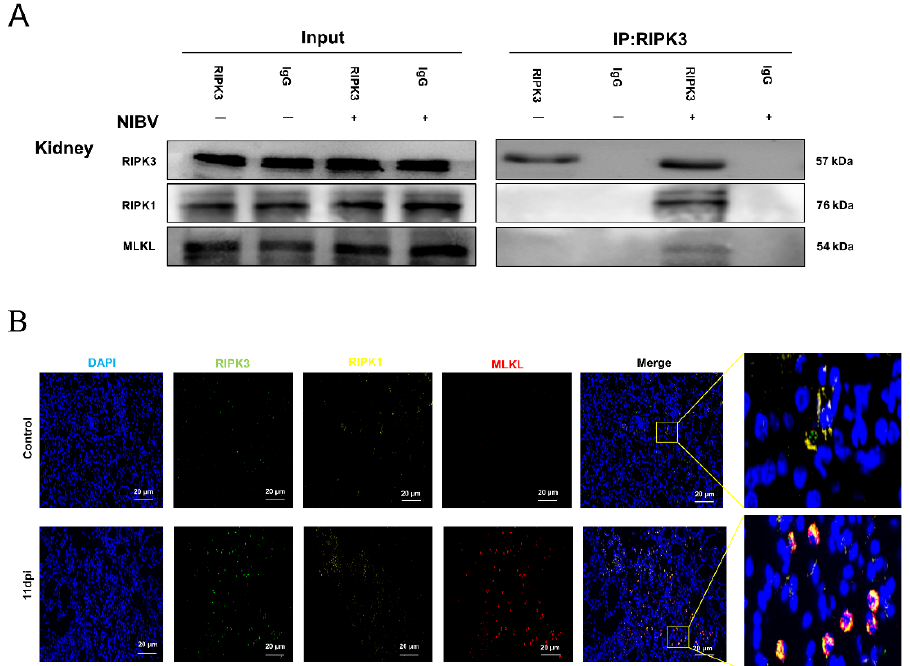
Figure 7. NIBV infection induces necroptosis. ( A ) Immunoprecipitation showed that RIPK3–RIPK1 and RIPK3–MLKL interactions were increased in the renal tissues after NIBV inoculation for 11 d. The whole-kidney tissue homogenate extracts were immunoprecipitated with prepared RIPK3 antibody as described in Materials and Methods 4.9. The immunocomplexes were analyzed by Western blot using the indicated antibodies. In addition, the Input group was subjected to SDS-PAGE followed by Western blot analysis of RIPK1, RIPK3, and MLKL. ( B ) Fluorescence microscopy analyzed the colocalization of the RIPK1 (yellow) and MLKL (red) with RIPK3 (green) in renal tissues after NIBV infection for 11 dpi. RIPK3 proteins were highly colocalized with RIPK1 and MLKL compared with the control group. Scale bar: 20 μm.